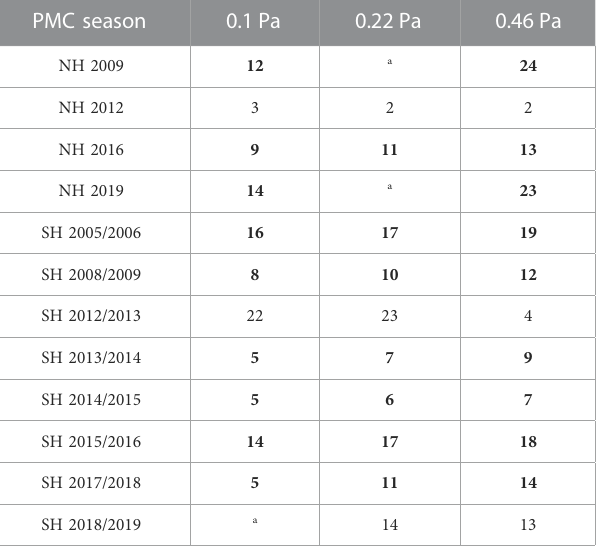
a represents no key date for the PMC seasons. The bold values indicate the cases with a distinct pattern of increasing time lags with increasing atmospheric pressure (decreasing